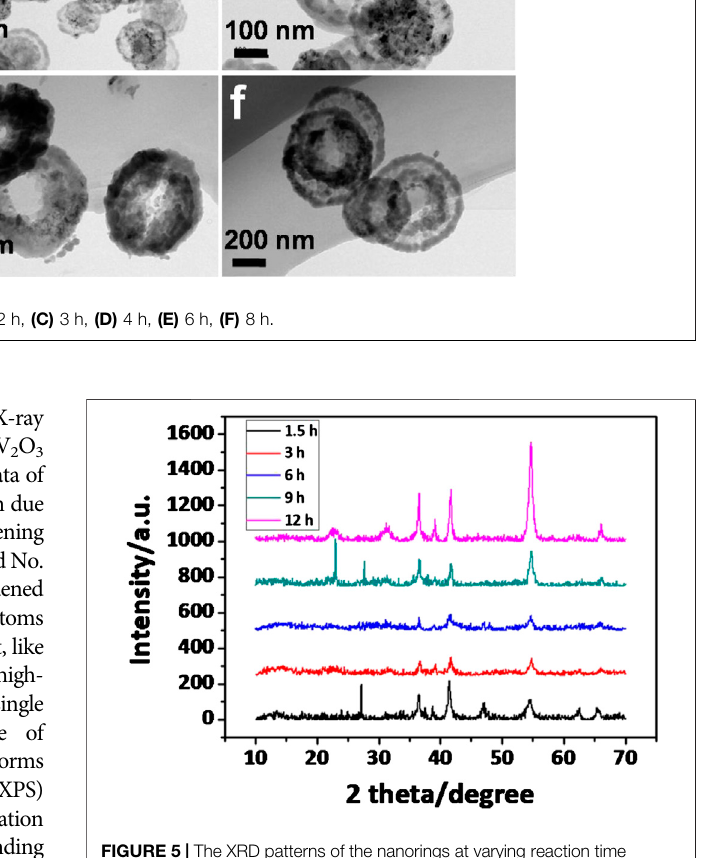
FIGURE 5 | The XRD patterns of the nanorings at varying reaction time (0 – 12